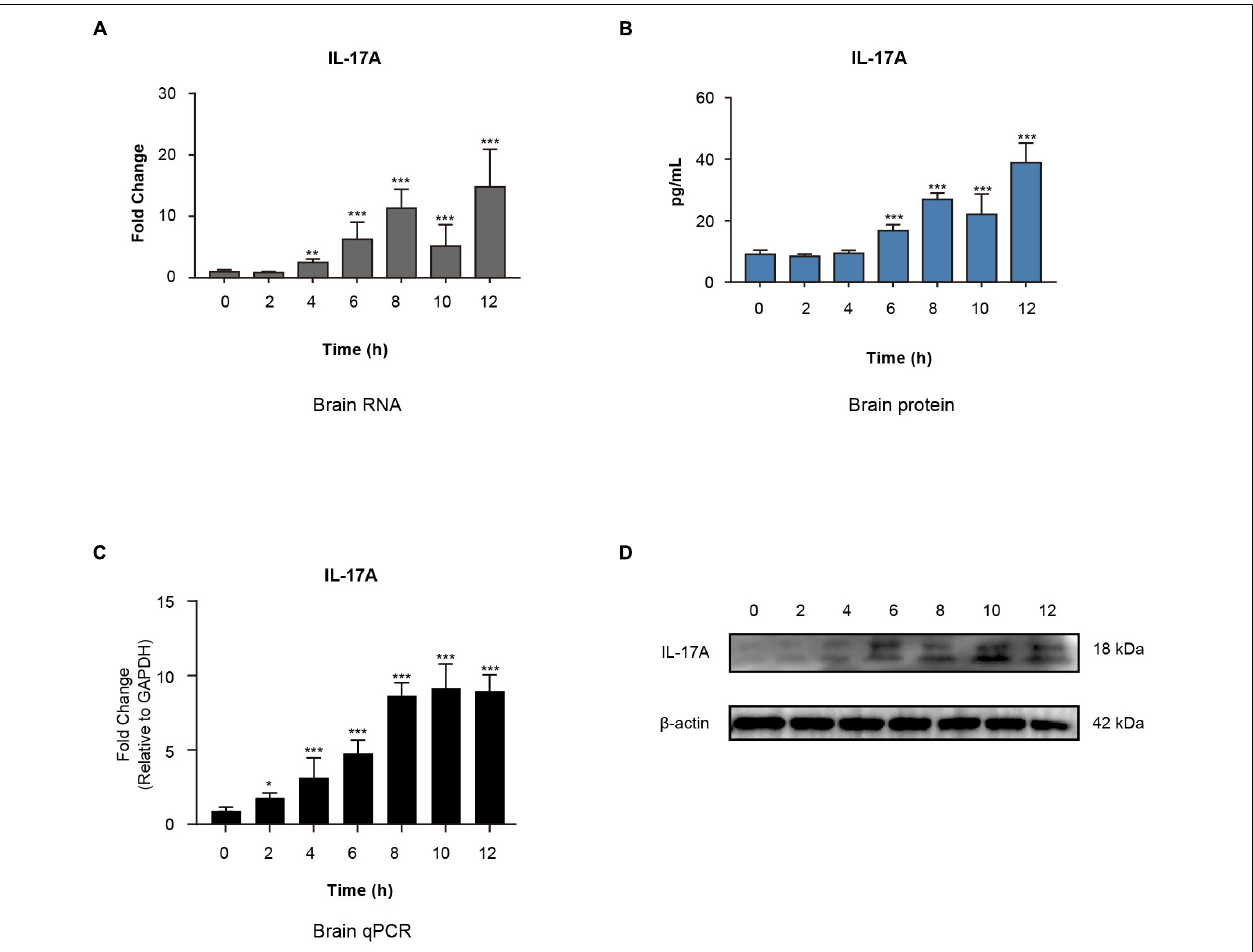
FIGURE 1 | Interleukin-17A expression in mouse brains triggered by E. coli infection. Quantification of IL-17A expression in the brains of E. coli challenged mice at both the transcriptional and protein levels by applying QuantiGene Plex 2.0 Assay (A) or Procartaplex Multiplex Immunoassays (B) . ** p < 0.01 and *** p < 0.001 by one-way ANOVA analysis. Data were collected and presented as mean ± SD from three replicates at each time point. (C) Real-time PCR verification of the IL-17A mRNA transcription in the brains of E. coli challenged mice. Data were collected and presented as mean ± SD from three replicates at each time point. * p < 0.05 and *** p < 0.001 by one-way ANOVA analysis. (D) Western blot verification of the IL-17A protein expression in the brains of E. coli challenged mice. β -Actin was used as the loading